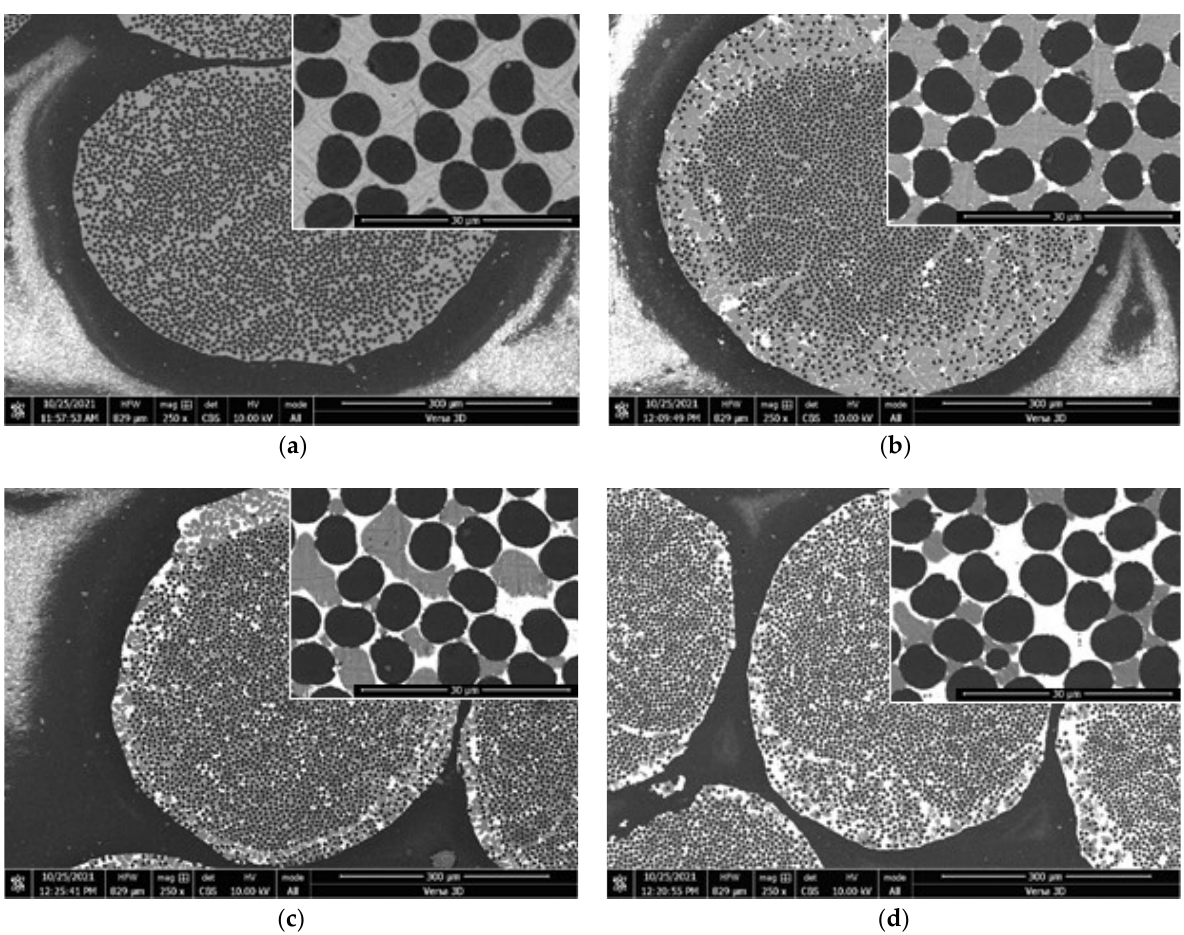
Figure 7. Microstructure of a CF/Al-Sn composite with tin content from 0 to 50 at.%: ( a ) 0% Sn, ( b ) 10% Sn, ( c ) 25% Sn, ( d ) 50% Sn.